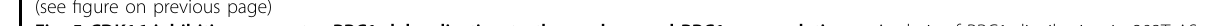
Fig. 5 CDK16 inhibition promotes PRC1 delocalization to the nucleus and PRC1 accumulation. a Analysis of PRC1 distribution in 293T AS- CDK16 cells after 3MBPP1 treatment (0, 5 and 10 µM) and subcellular fractionation. The columns represent the means ± SEMs of 9 independent experiments. b Representative images of PRC1 immuno fl uorescence (red) and the Na + /K + ATPase (membrane marker) in 293T AS-CDK16 cells treated with 0 (control), 5 or 10 µM 3MBPP1. c PRC1 accumulation in 293T and 293T AS-CDK16 cells treated with 3MBPP1 (0, 5 and 10 µM) for 6 h was assessed by western blotting. The columns represent the means ± SEMs of 12 independent experiments. * P < 0.05, ** P < 0.01 vs control; Mann – Whitney test. d Analysis of PRC1 distribution in HT-29 colon cancer cells after treatment with dabrafenib (0, 2 and 10 nM) for 24 h and subcellular fractionation. The columns represent the means ± SEMs of 8 independent experiments. e Representative images of PRC1 immuno fl uorescence (red) and the Na + /K + ATPase in HT-29 cells treated with 0 (control), 2 or 10 nM dabrafenib for 24 h. f PRC1 accumulation in HT- 29 cells treated with 2 nM dabrafenib for 24 h was assessed by western blotting. The columns represent the means ± SEMs of 8 independent experiments. * P < 0.05 vs nontreated (NT) cells, Mann – Whitney